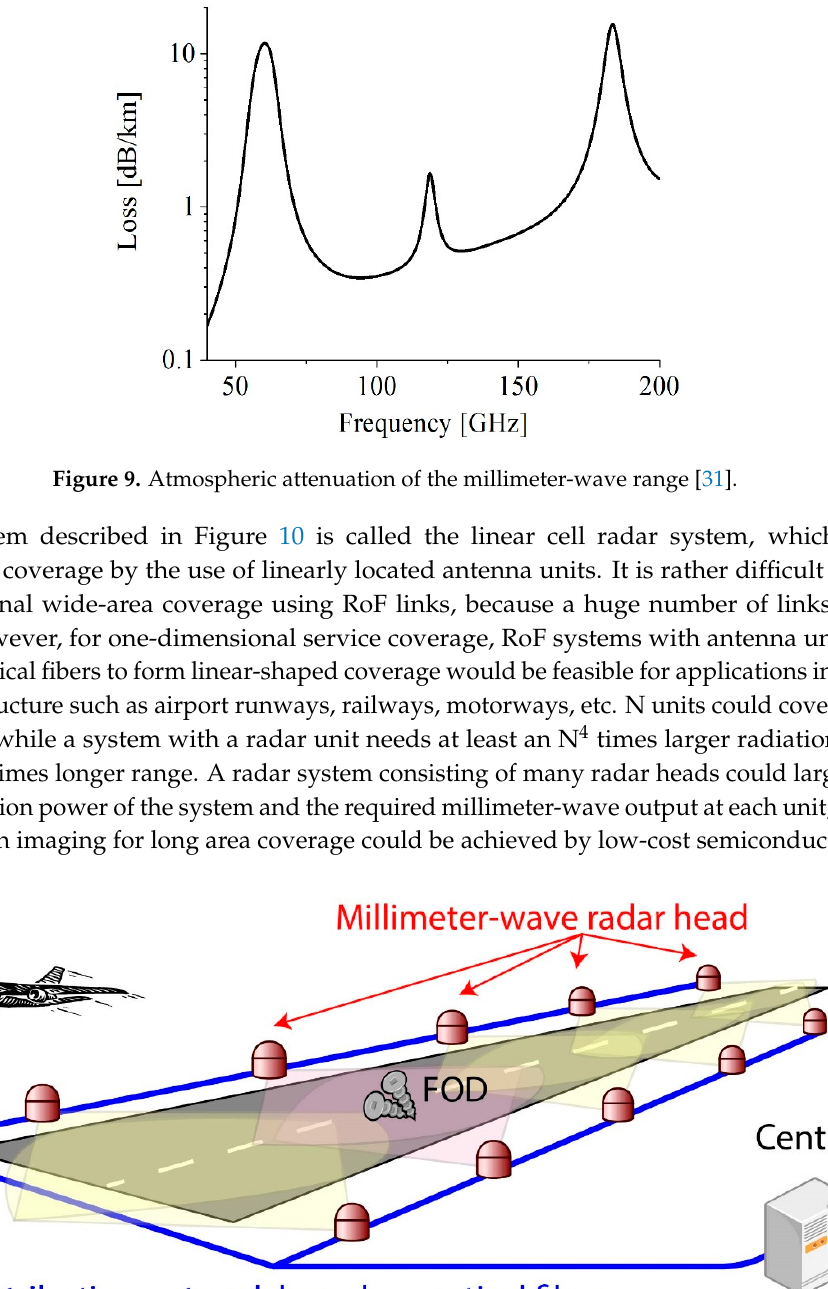
Figure 9. Atmospheric attenuation of the millimeter-wave range [31].